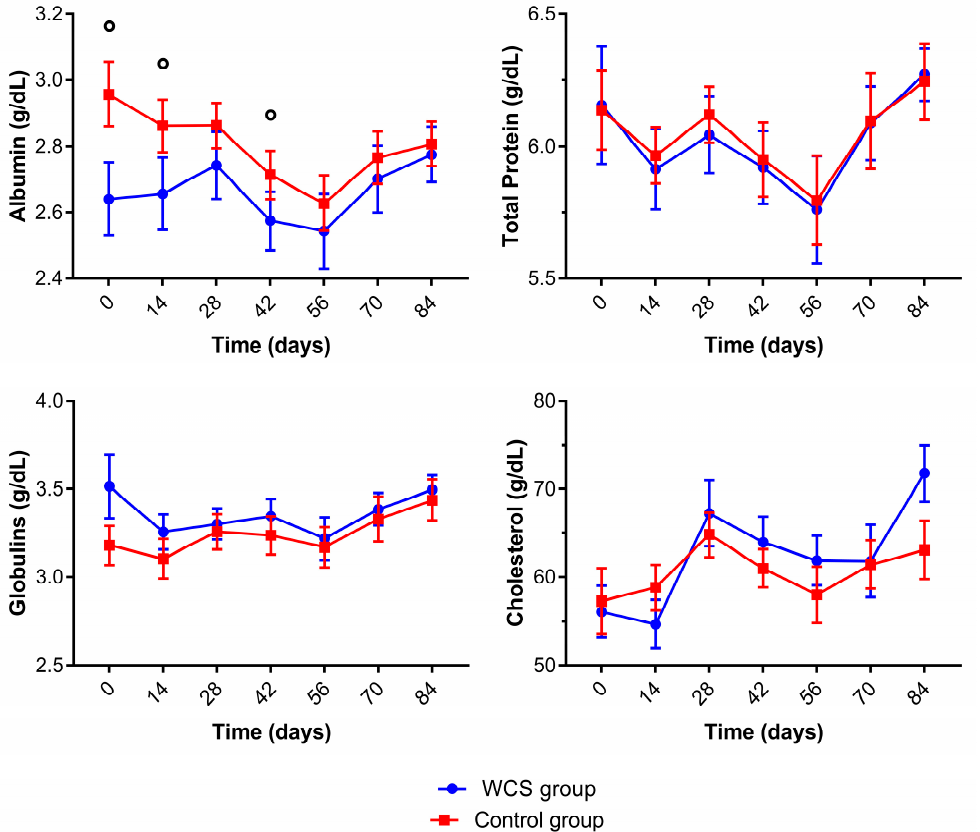
Figure 3. The mean (±standard error of the mean) of albumin, total protein, globulins, and cholesterol concentrations of crossbred lambs naturally infected with gastrointestinal nematodes and Eimeria spp. receiving two different diets (whole cottonseed and control) at seven different samplings (0–84 days). There was an interval of 14 days between each sample collection. ◦ Significantly difference between